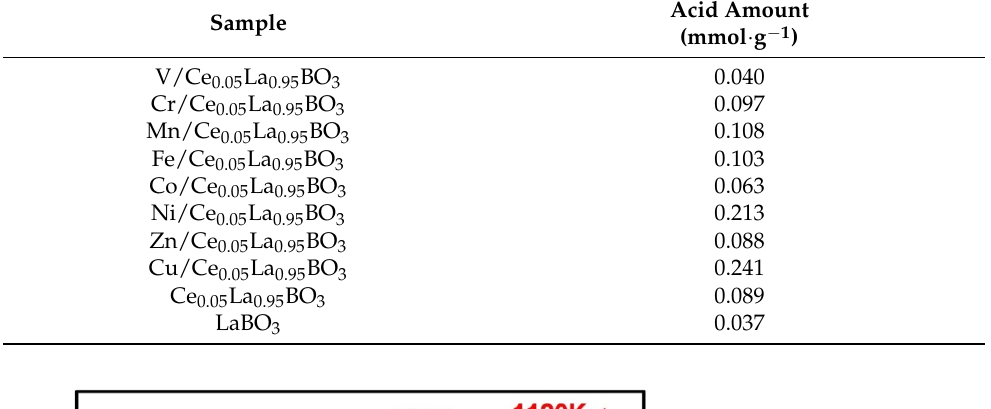
Table 2. Potentiometric titration employing n-butylamine for LaBO 3 , Ce 0.05 La 0.95 BO 3 , and TMs/Ce 0.05 La 0.95 BO 3 .